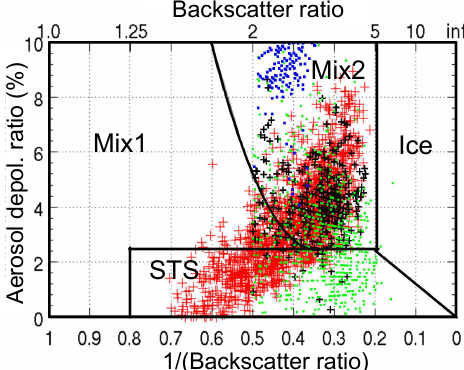
Figure 10. Scatterplot of aerosol depolarization ratio versus backscatter ratio as measured by the lidars MAL1 and MAL2 (red crosses) on 20 January (see Fig 5), and near in situ by the backscat- ter sonde MAS on 17 January (green squares), 20 January (black crosses) and 25 January 2010 (blue squares). The black lines are phase boundaries for different (lidar) PSC types adopted from the scheme described in Pitts et al. (2011). Mix1 and Mix2 are mix- tures of liquid droplets and solid NAT particles defined for different number densities of NAT particles. Mix2 represents NAT number densities above 10 − 3 cm − 3